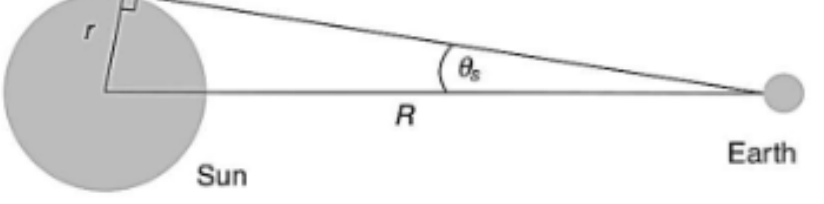
Figure 7. Sampling cone of the rays coming from the solar disk.